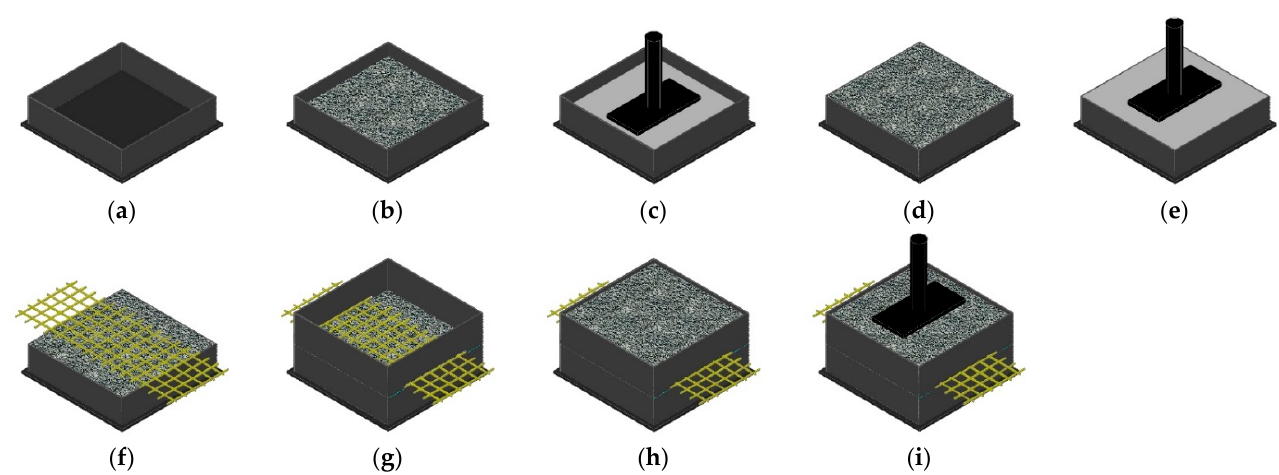
Figure 3. MD test assembly sequence: ( a ) lower box; ( b ) placement and ( c ) compaction of the first sublayer of corundum ; ( d ) placement and ( e ) compaction of the second sublayer of corundum ; ( f ) placement of the specimen (in yellow); ( g ) upper box assembly; ( h ) placement of the loose layer of corundum ; ( i ) application of the dynamic loading.